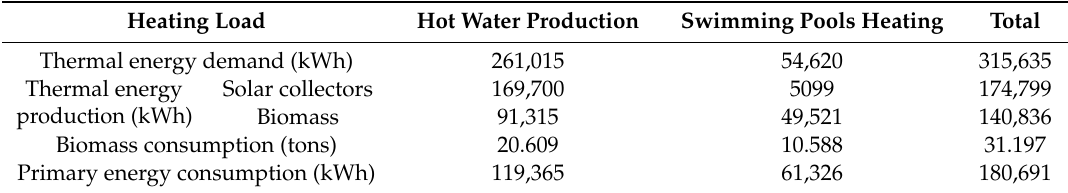
Table 8. New thermal power demand and analysis of thermal power production with the proposed solar-combi system.